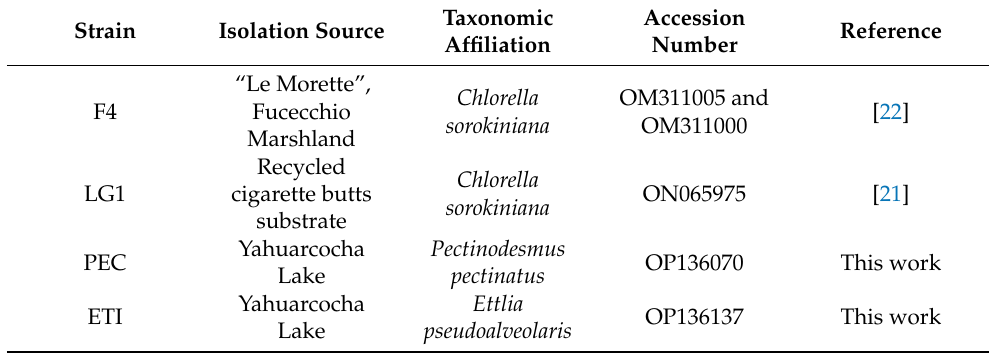
Table 2. List of microalgal